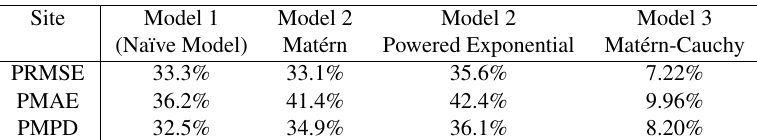
Table 6. Average Performance of Models 1-3 to Model 4